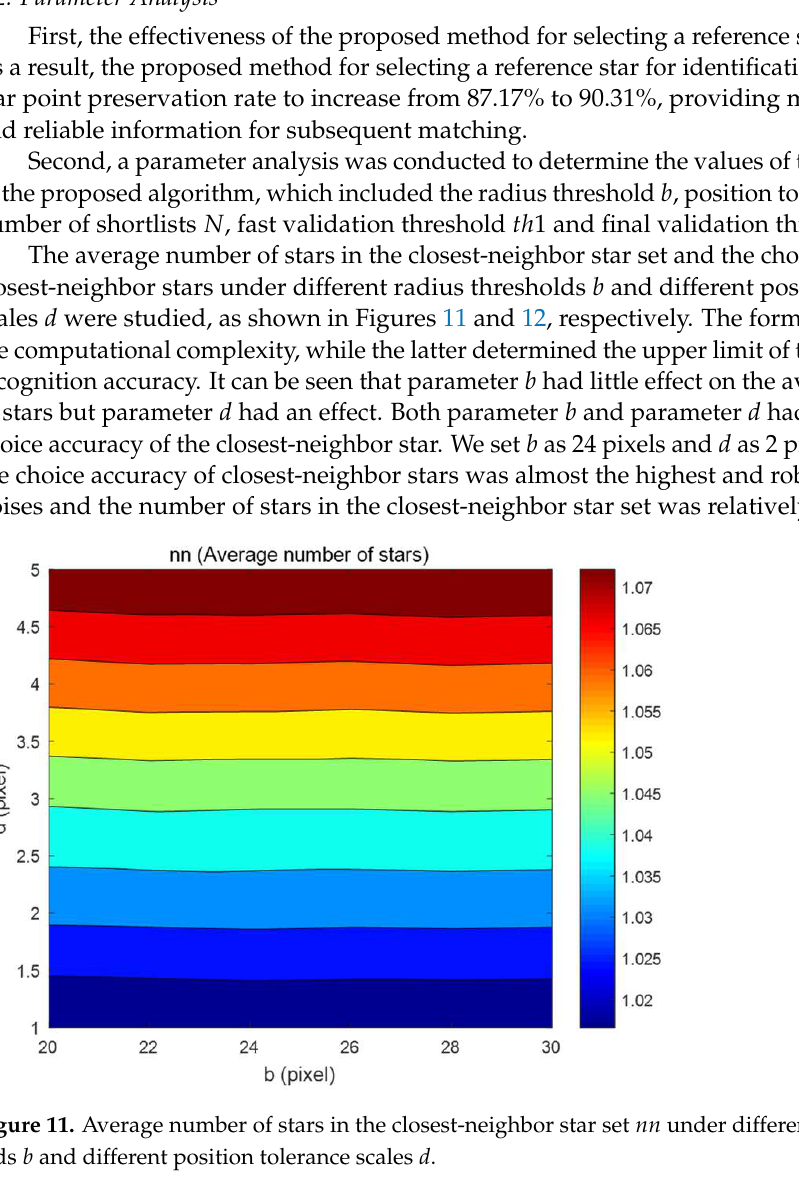
Figure 10. Distributing points evenly on a sphere.